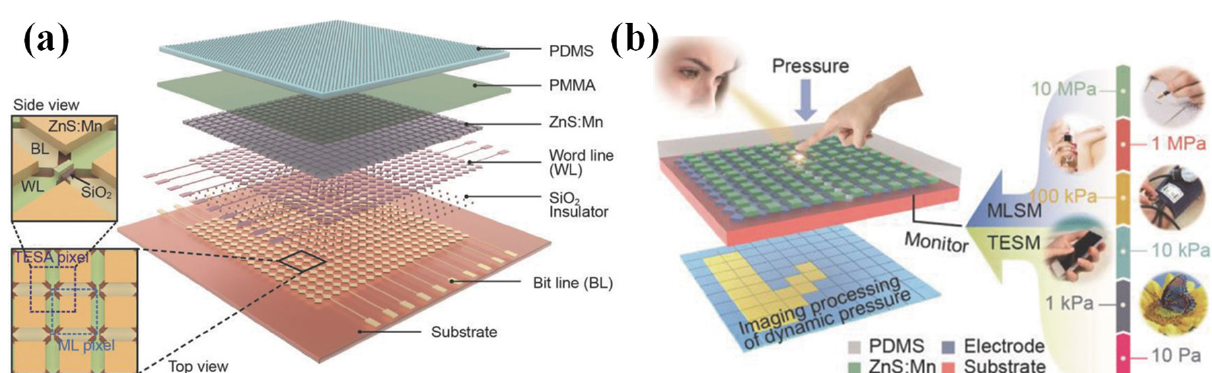
Figure 7. ( a ) A full-dynamic-range pressure sensor matrix based on dual-mode optical and electrical sensing. Reproduced with permission from Ref. [99]. Copyright 2017, WILEY-VCH. ( b ) Diagram of pressure regimes and the relevant applications in our daily lives. Reproduced with permission from Ref. [99]. Copyright 2017, WILEY-VCH.